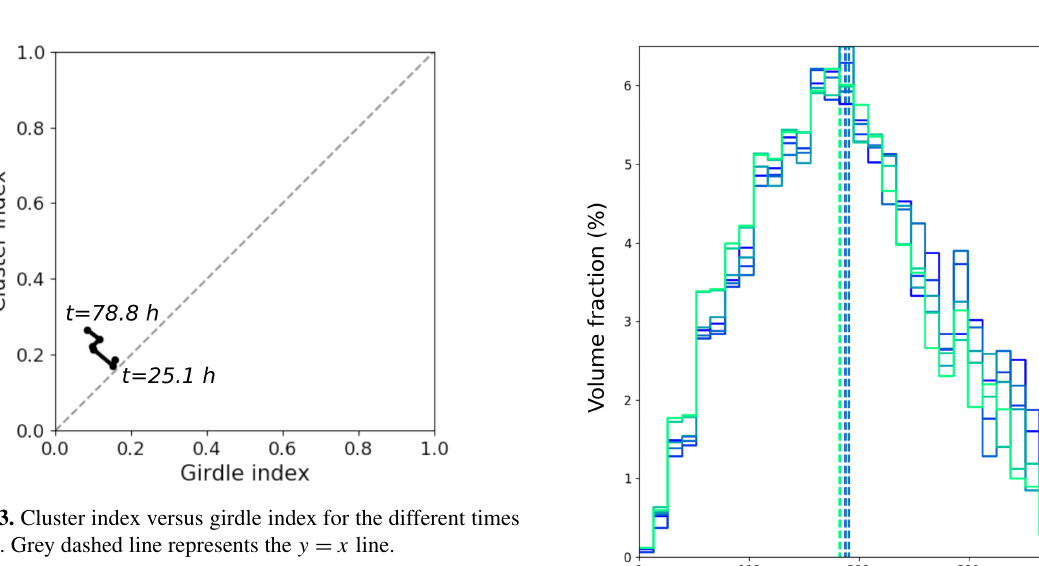
Figure 12. Evolution of the eigenvectors of the orientation tensors represented in the pole figure with vertical axes as reference (a) and eigenvalues (b) . Colours of dots for eigenvector on the left correspond to eigenvalue colours on the right.